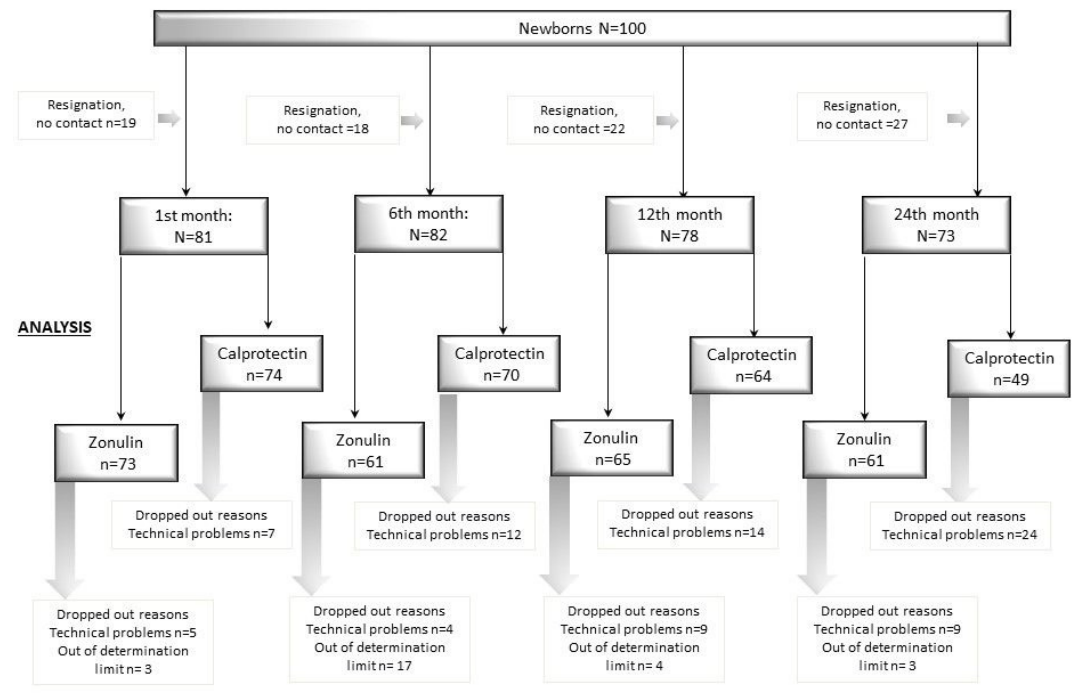
Figure 1. Study flow chart. Out of determination limit: see Materials and Methods. Technical problems: too little material.